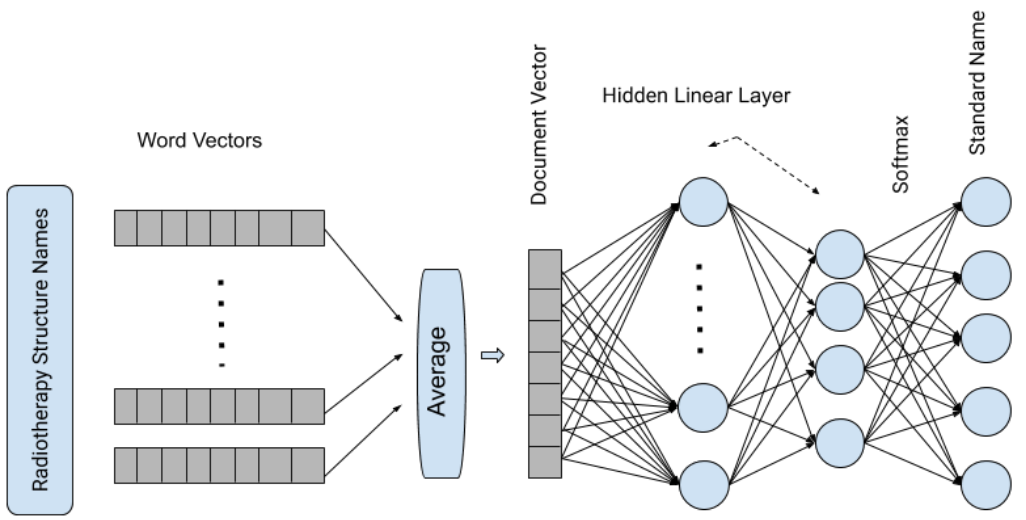
Figure 2. Pictorial representation of fastText supervised classification